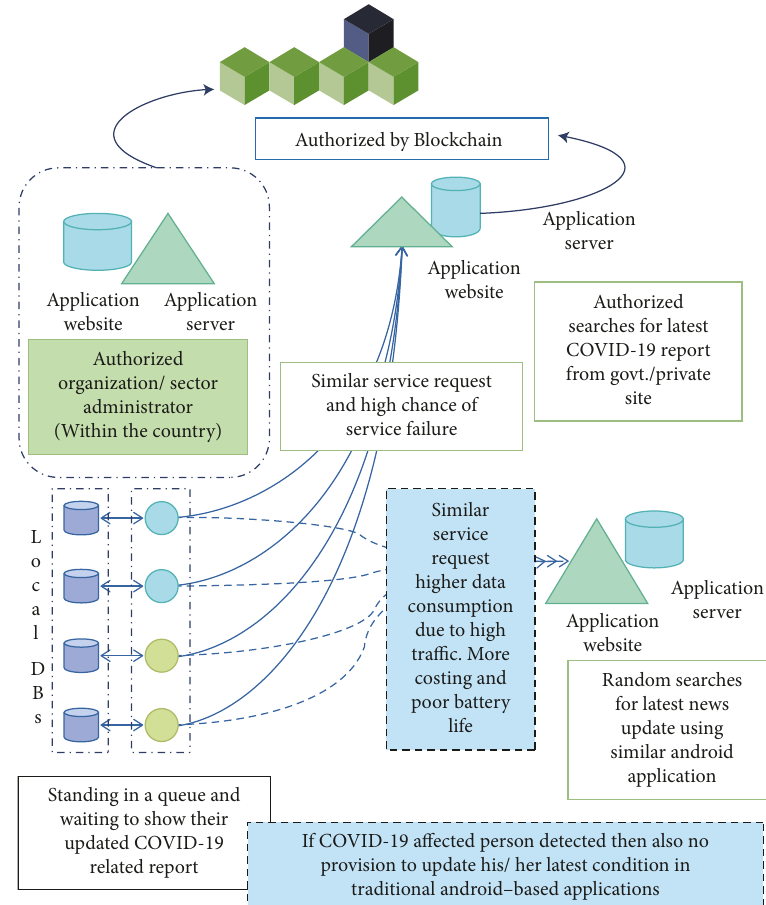
Figure 2: Request for in-country service